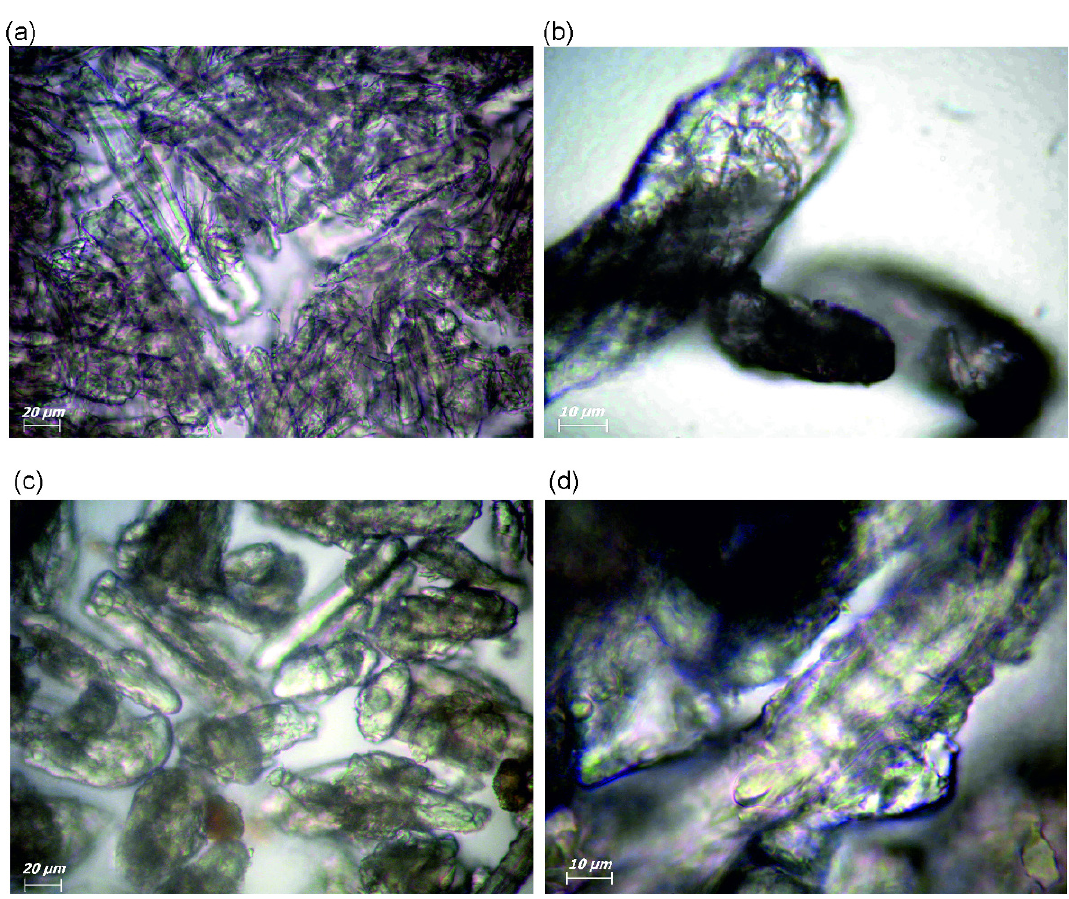
Figure 2. Microphotographs (Primo Star optical microscope, Carl Zeiss) of (a, b) hydrated MCC and (c, d) NC with magnification: (a, c) ×400 and (b, d) ×1000 (scale bar 20 µm (a, c) and 10 µm (b,